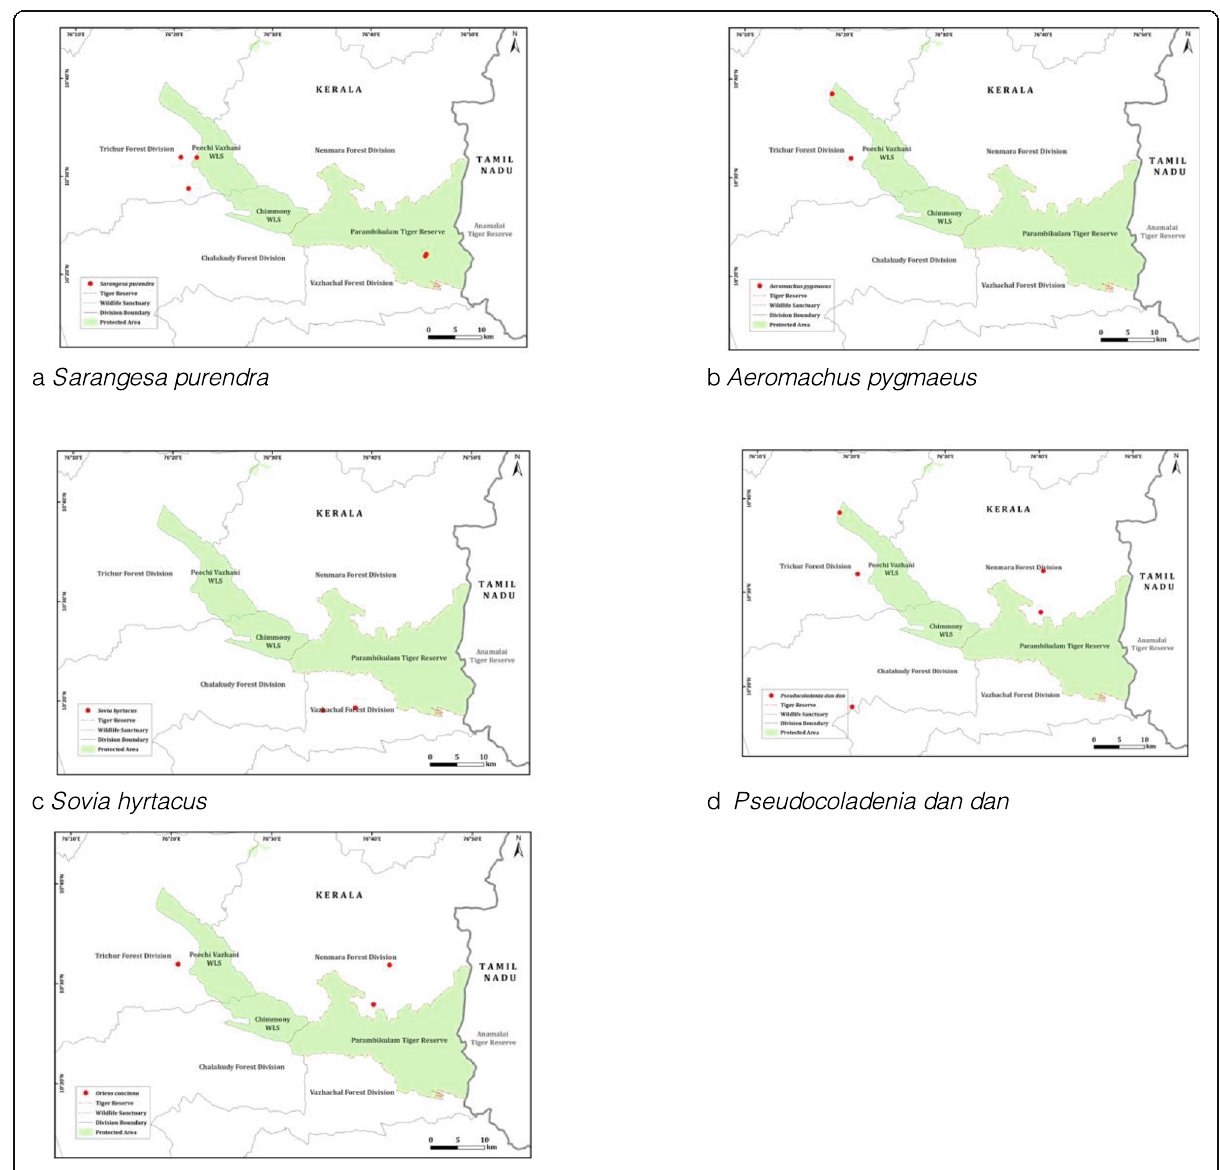
Fig. 7 a - e Distribution maps of endemic butterflies of family Hesperidae within study area. a Sarangesa purendra . b Aeromachus pygmaeus . c Sovia hyrtacus . d Pseudocoladenia dan dan . e Oriens